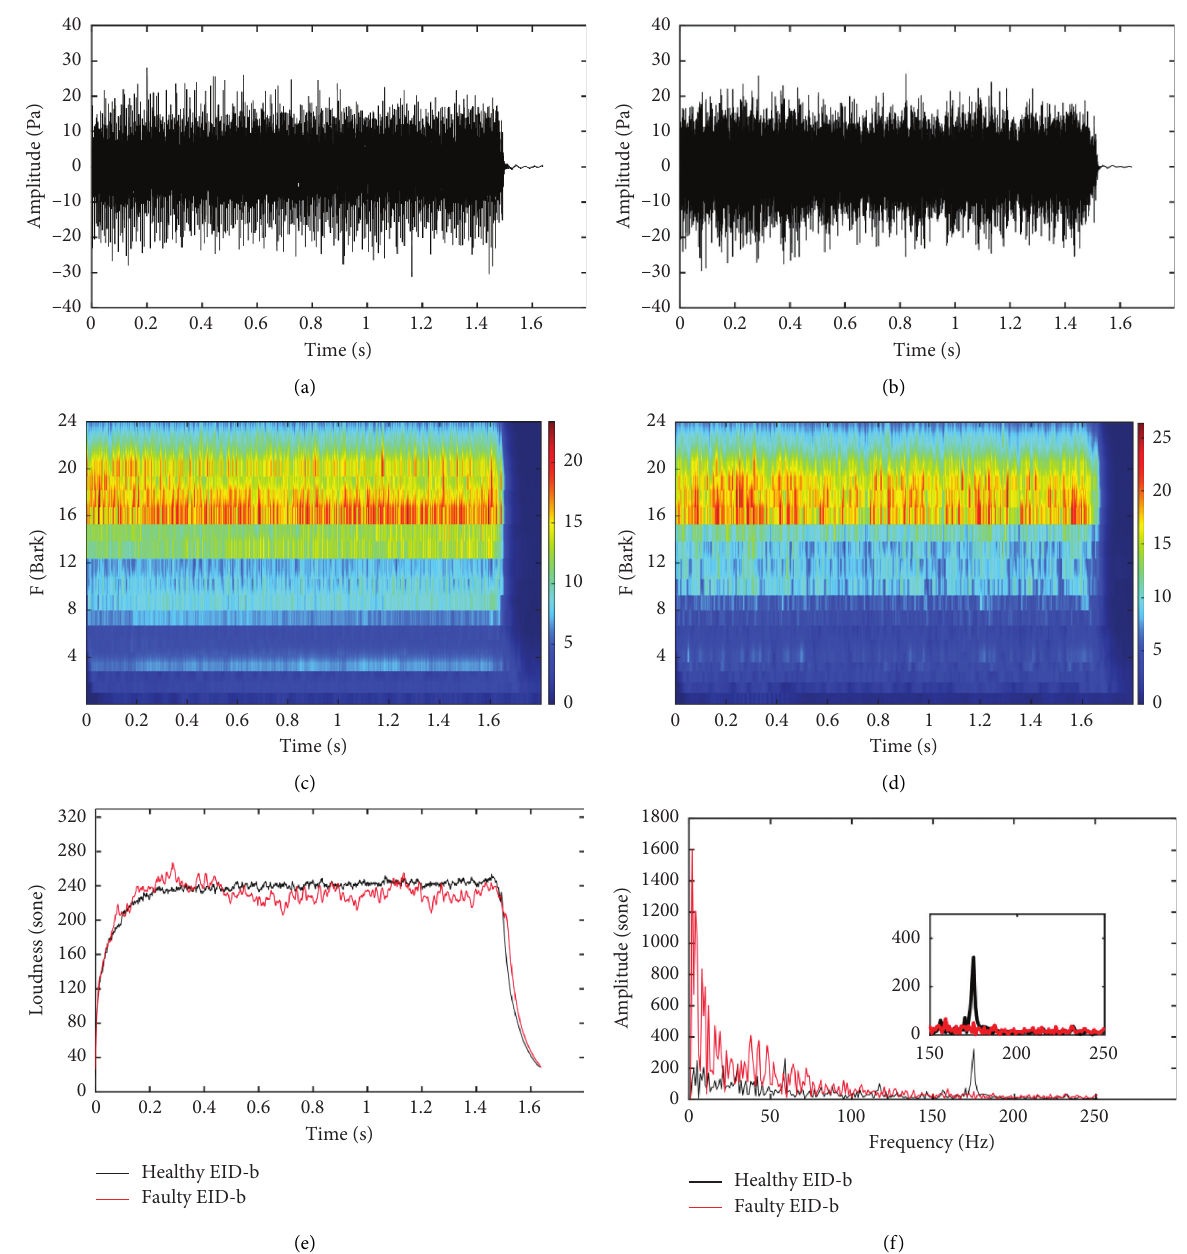
Figure 8: Acoustic signal analysis of Case 2: (a) acoustic signal of healthy EID-b, (b) acoustic signal of faulty EID-b, (c) time-varying specific loudness of healthy EID-b, (d) time-varying specific loudness of faulty EID-b, (e) time-varying loudness of healthy EID-b and faulty EID-b, and (f) time-varying loudness spectrum of healthy EID-b and faulty